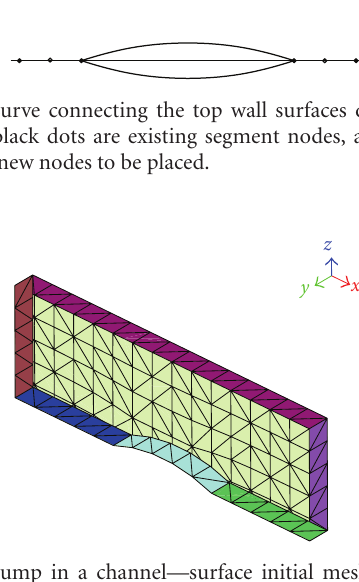
Figure 10: Projection curves and surfaces during the smoothing iterations—(a) without projection of all nodes, (b) with projection after each smoothing